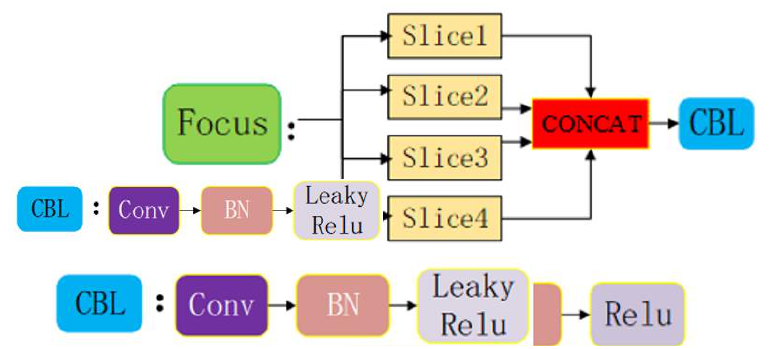
Figure 3. The structure of the focus layer.